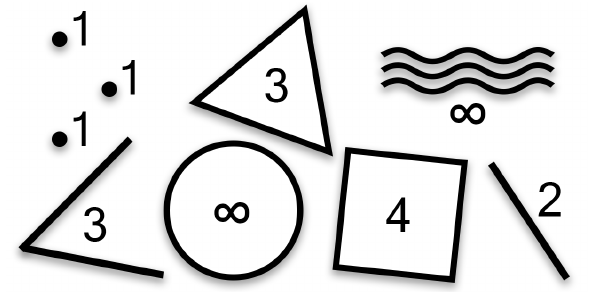
Figure 1. Different geometrical features with corresponding nodes count.